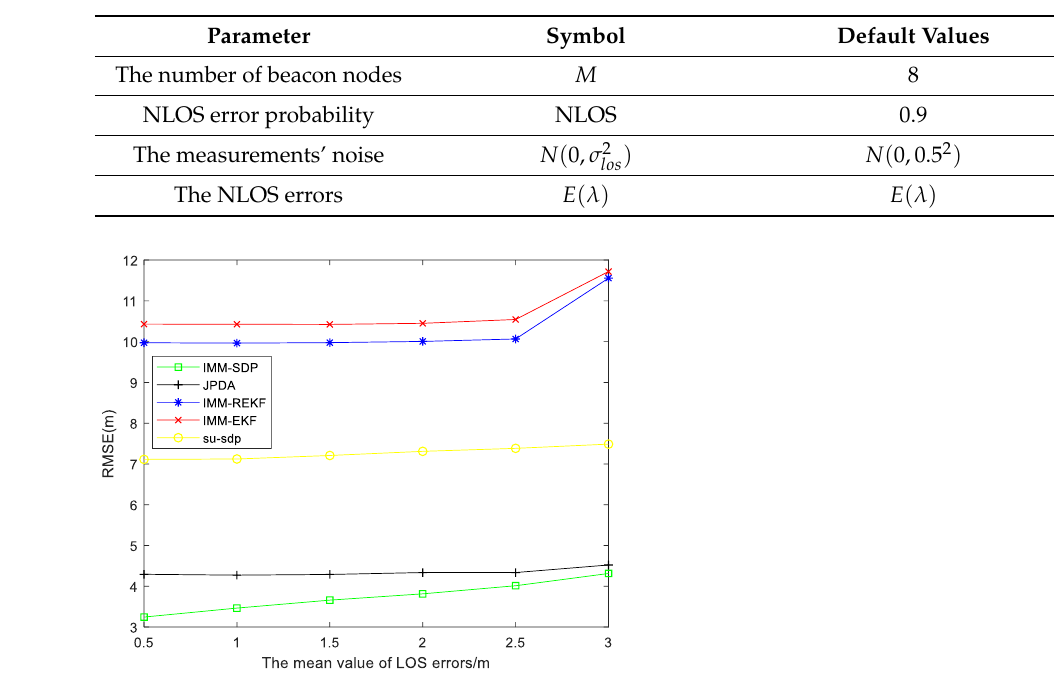
Figure 7. RMSE versus the different probability of LOS errors.